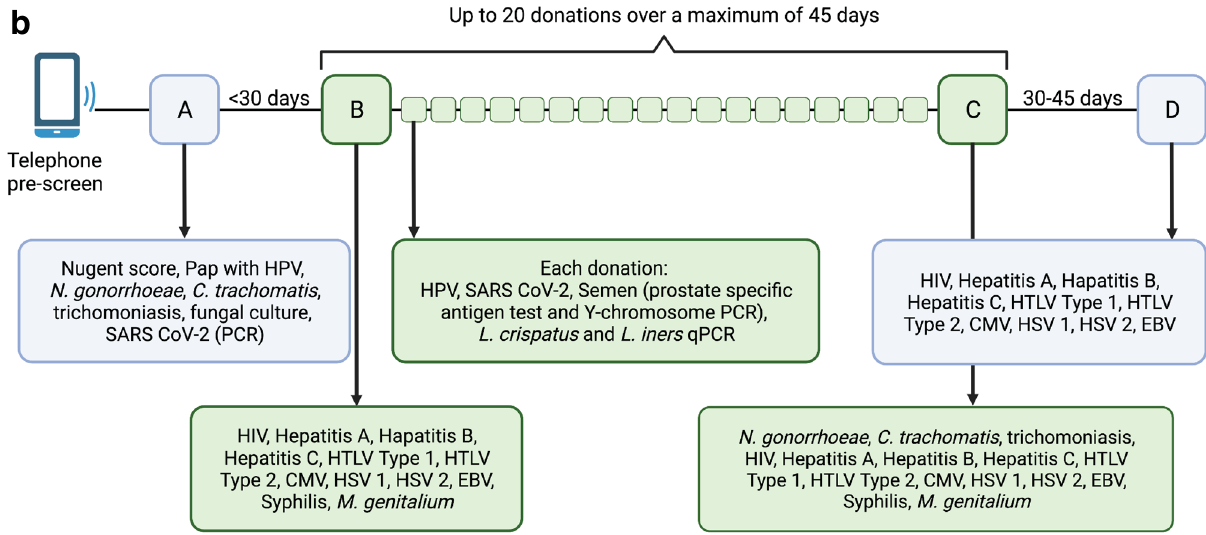
Figure 2. Donor screening and donation schedule. ( a ) 50 total women, including the pilot donor (light green), were pre-screened over the phone. Eight potential donors completed an in-person screen and testing, three of whom went on to become donors (dark green), four of whom were ineligible due to high Nugent scores (red), and one of whom was ineligible due to a recent blood donation and no subsequent follow-up (pink). Twenty- three potential donors (grey) were uninterested in following up or were disqualified for logistical reasons (e.g., travel), 18 completed pre-screening and asked for later follow up (yellow). ( b ) Donation screening and schedule with detailed testing for donors and donations before, during, and after